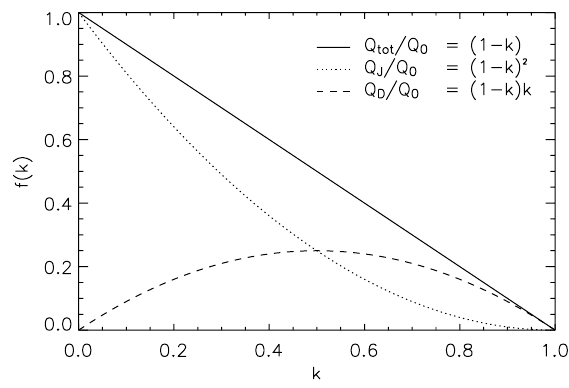
Fig. 1. Dependence of Q tot /Q 0 , Q J /Q 0 and Q D /Q 0 upon k